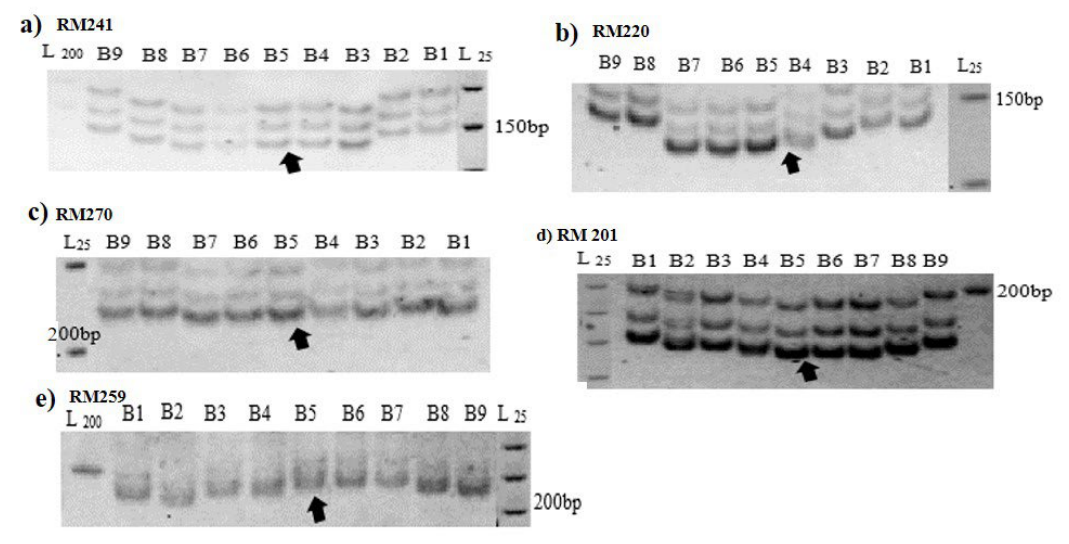
Supplemental Figure 1: Additional SSR marker profiles amplified